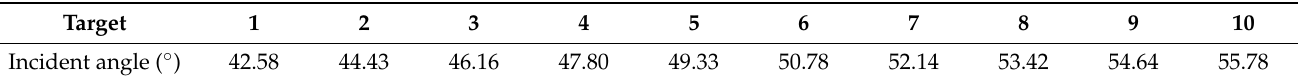
Figure 8. ( a ) The actual and reference track; ( b ) The target distribution diagram. The incident angles of targets are shown in Table 4. Table 4. The incident angles of simulation experiments.